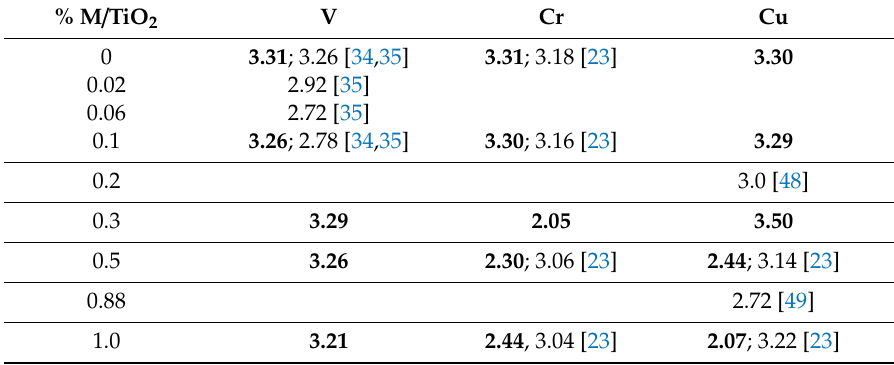
Table 2. Band gap values obtained for the metal surface-impregnated TiO 2 photocatalysts. The entries in bold were obtained in this work (M(X%)/TiO 2 -P25).